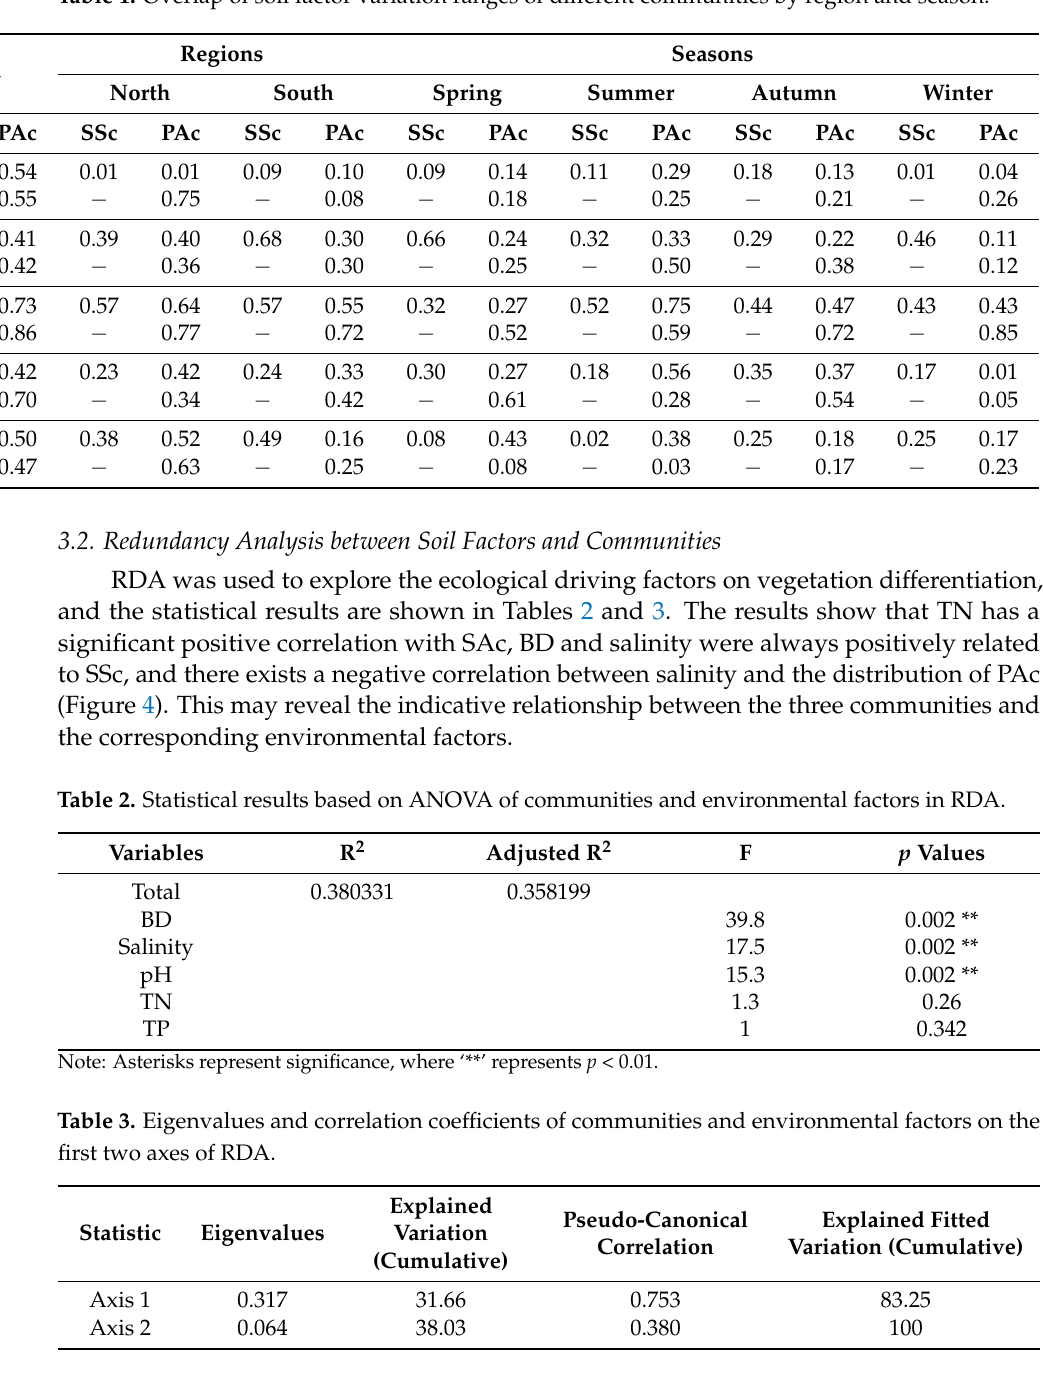
Table 1. Overlap of soil factor variation ranges of different communities by region and season.